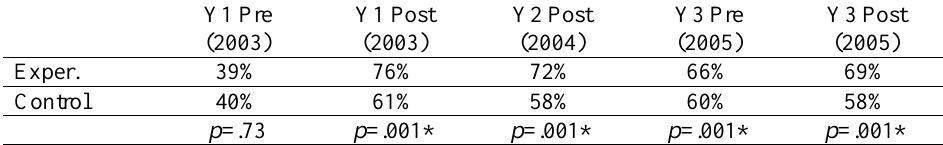
Table 1. Three-Year Longitudinal Knowledge Test Results from the Science PE, and Me! Curriculum Units for the Original 3rd Grade Cohort.